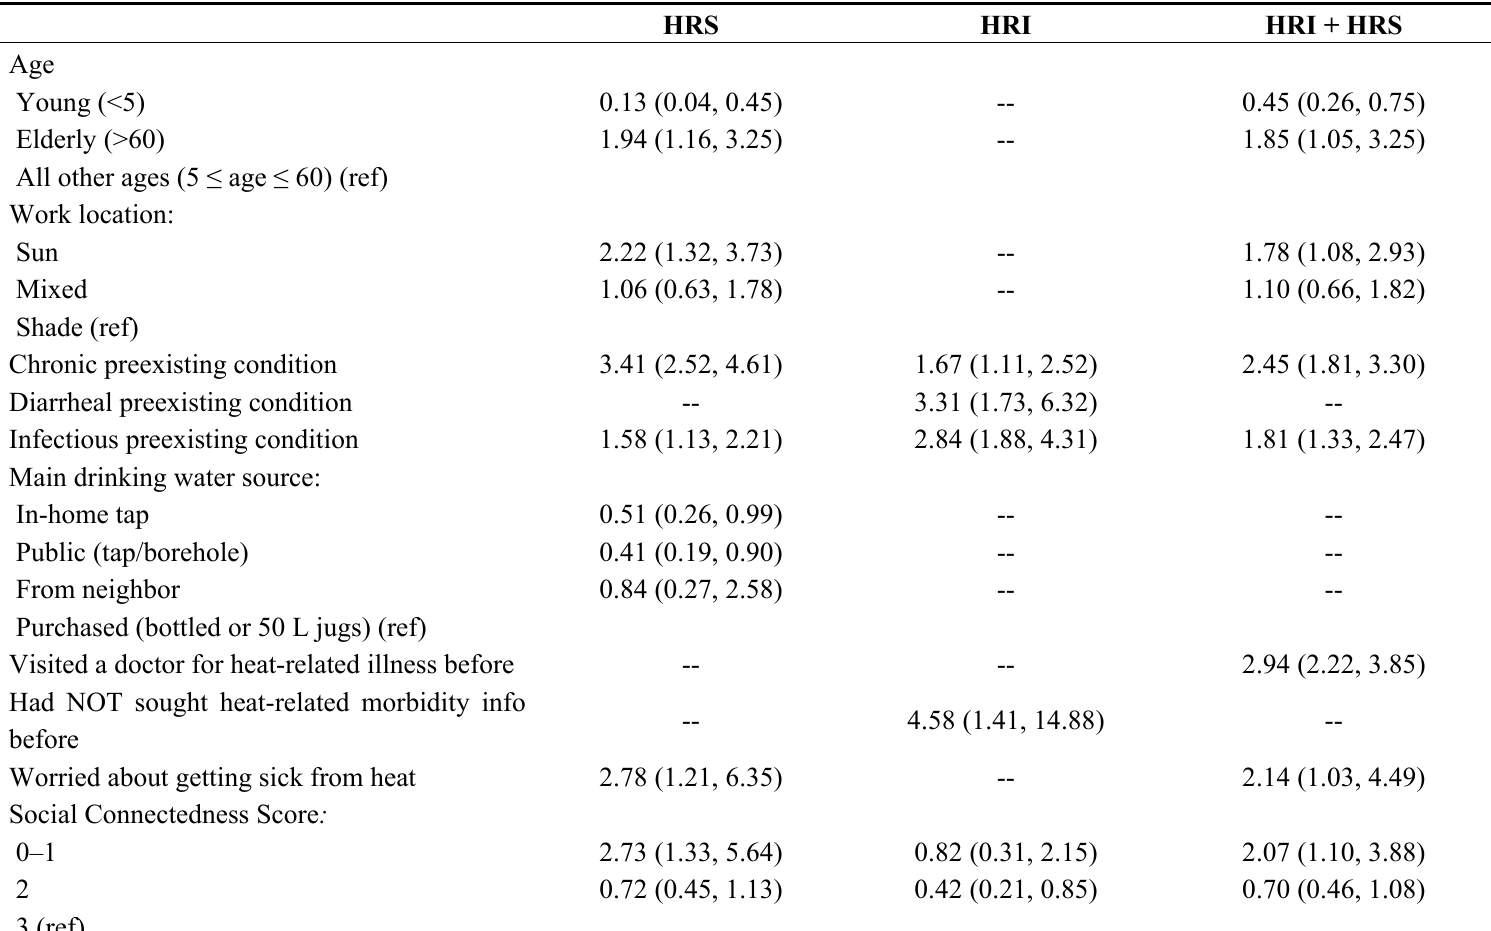
Table 3. Covariates included in final model for each heat-related outcome based on significance at the α = 0.05 level (heat-related symptoms, heat-related illnesses, and composite